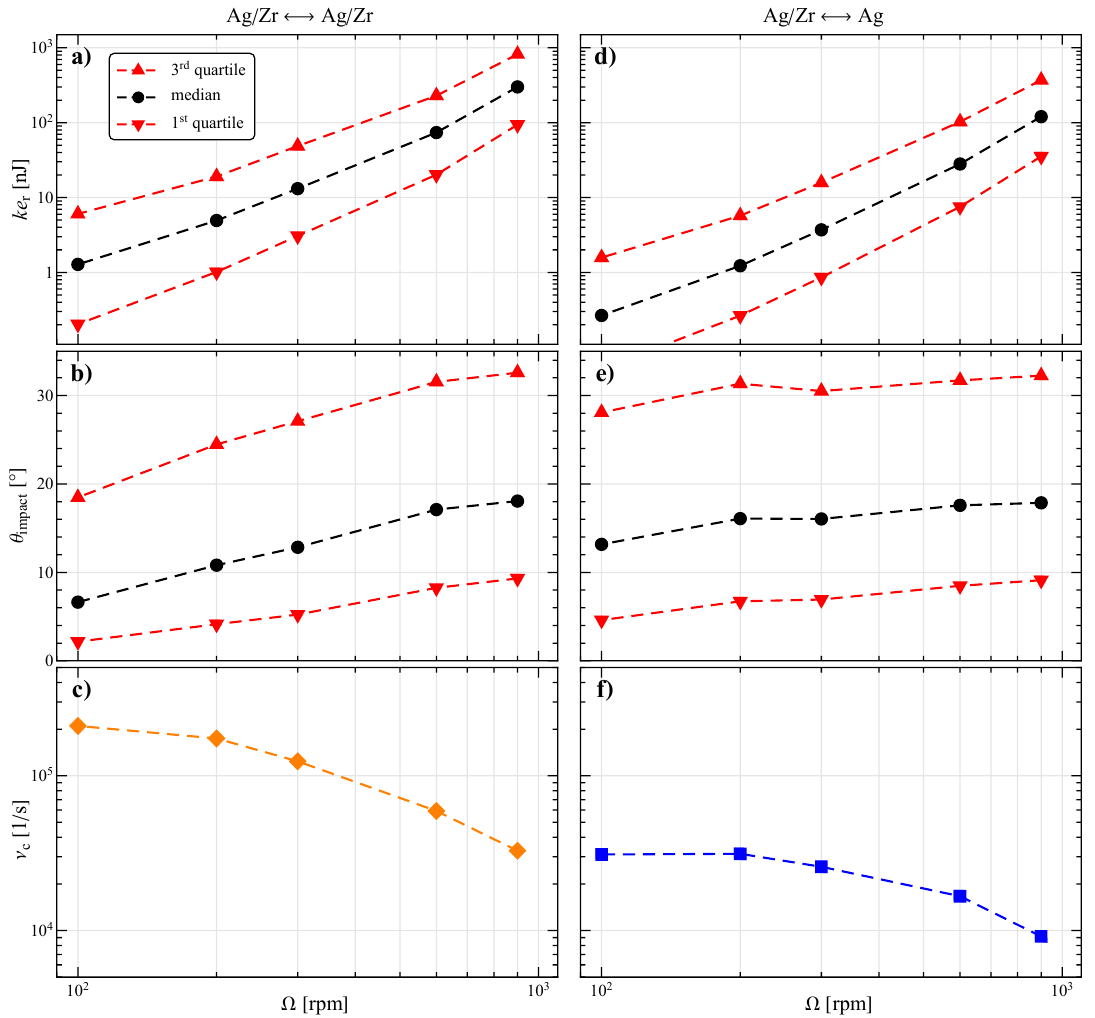
Figure 4. ( a , d ) Relative kinetic energy, ( b , e ) impact angle, and ( c , f ) collision frequency as a function of the stirring velocity for the impacts between all the particles (left column) and those involving at least an Ag particle (right column). In the first and second row the median, first, and third quartiles of the distribution are